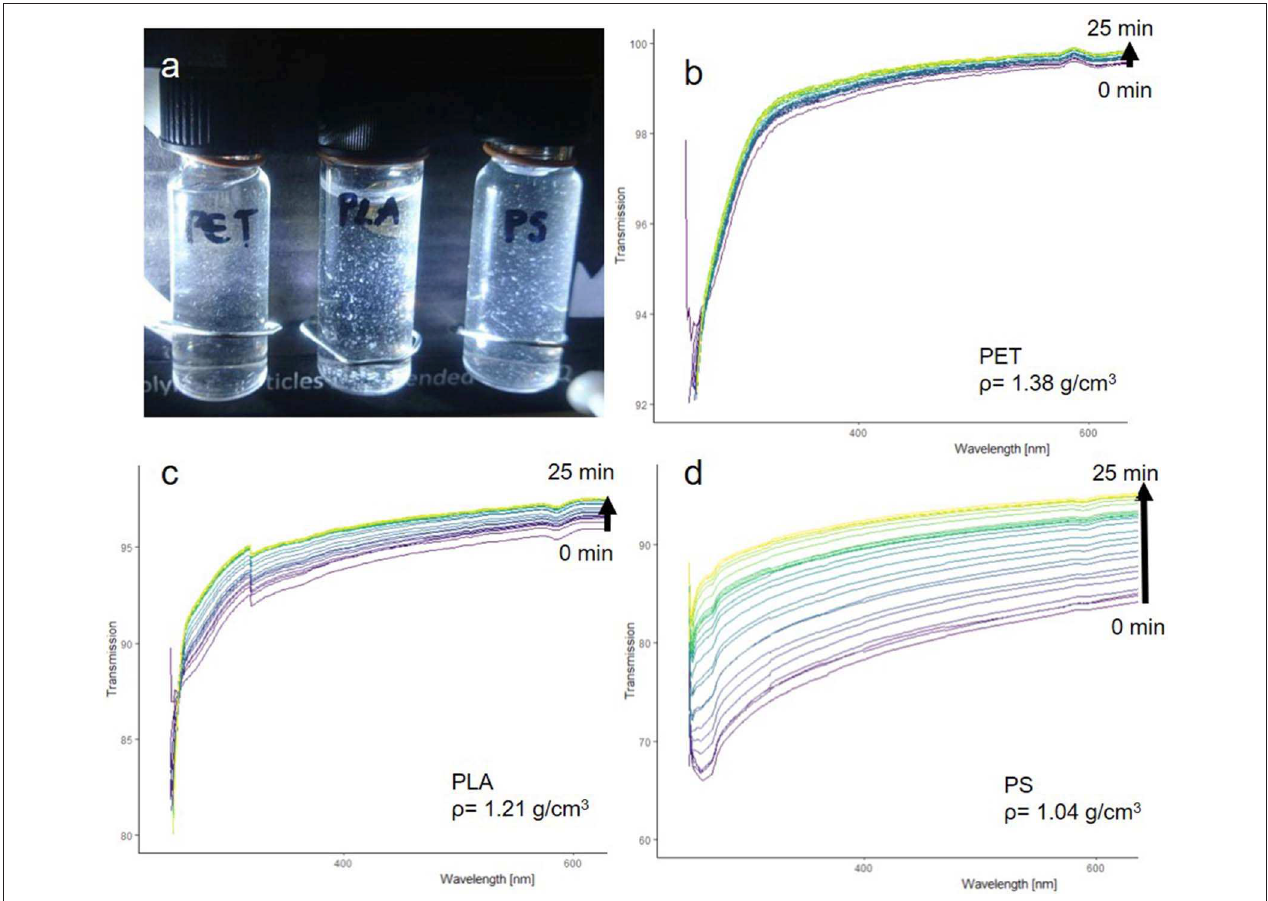
FIGURE 7 | PET, PLA, and PS fragments suspended in pure MilliQ water (a) . UV-VIS transmission spectra of PET (b) , PLA (c) , PS (d) .